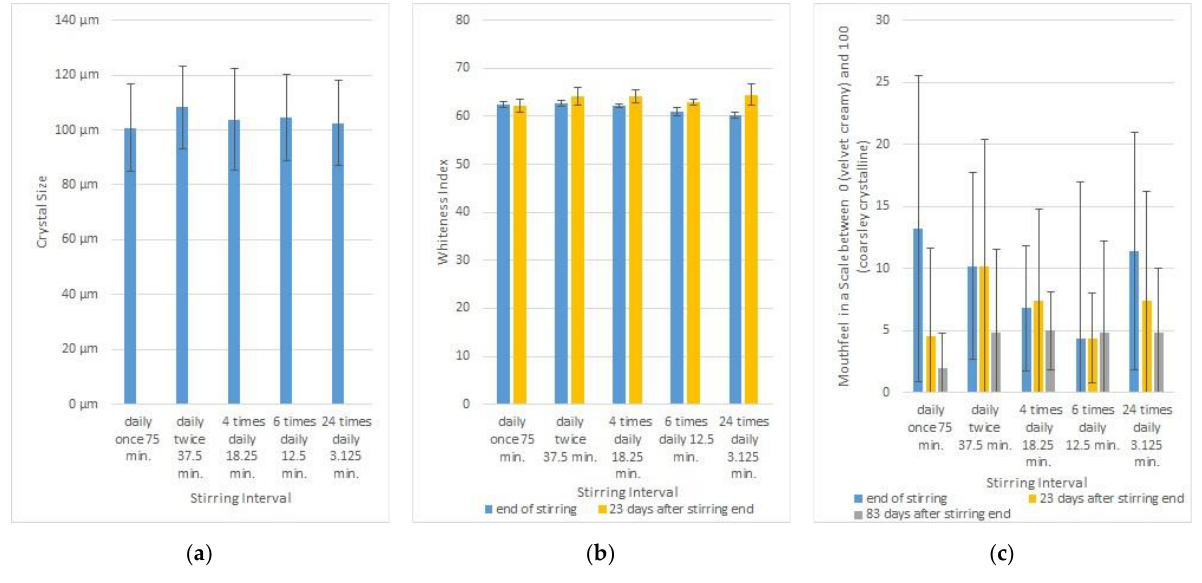
Figure 4. Influence of the stirring interval on the creaminess of honey. ( a ): Mean and standard deviation of the size of the 10 largest crystals on different days. ( b ): Mean and standard deviation of whiteness index of the honey on different days. ( c ): Mouthfeel of the honey, tested by 5 trained sensory testers on a scale between 0 (velvet creamy) and 100 (coarsely crystalline; average scale and standard deviation).